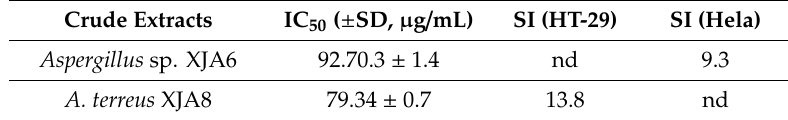
Table 6. IC 50 values of normal human embryonic kidney (HEK-293) cells and selectivity index (SI) values of antiproliferative crude extracts of Aspergillus sp. XJA6 and A. terreus XJA8.